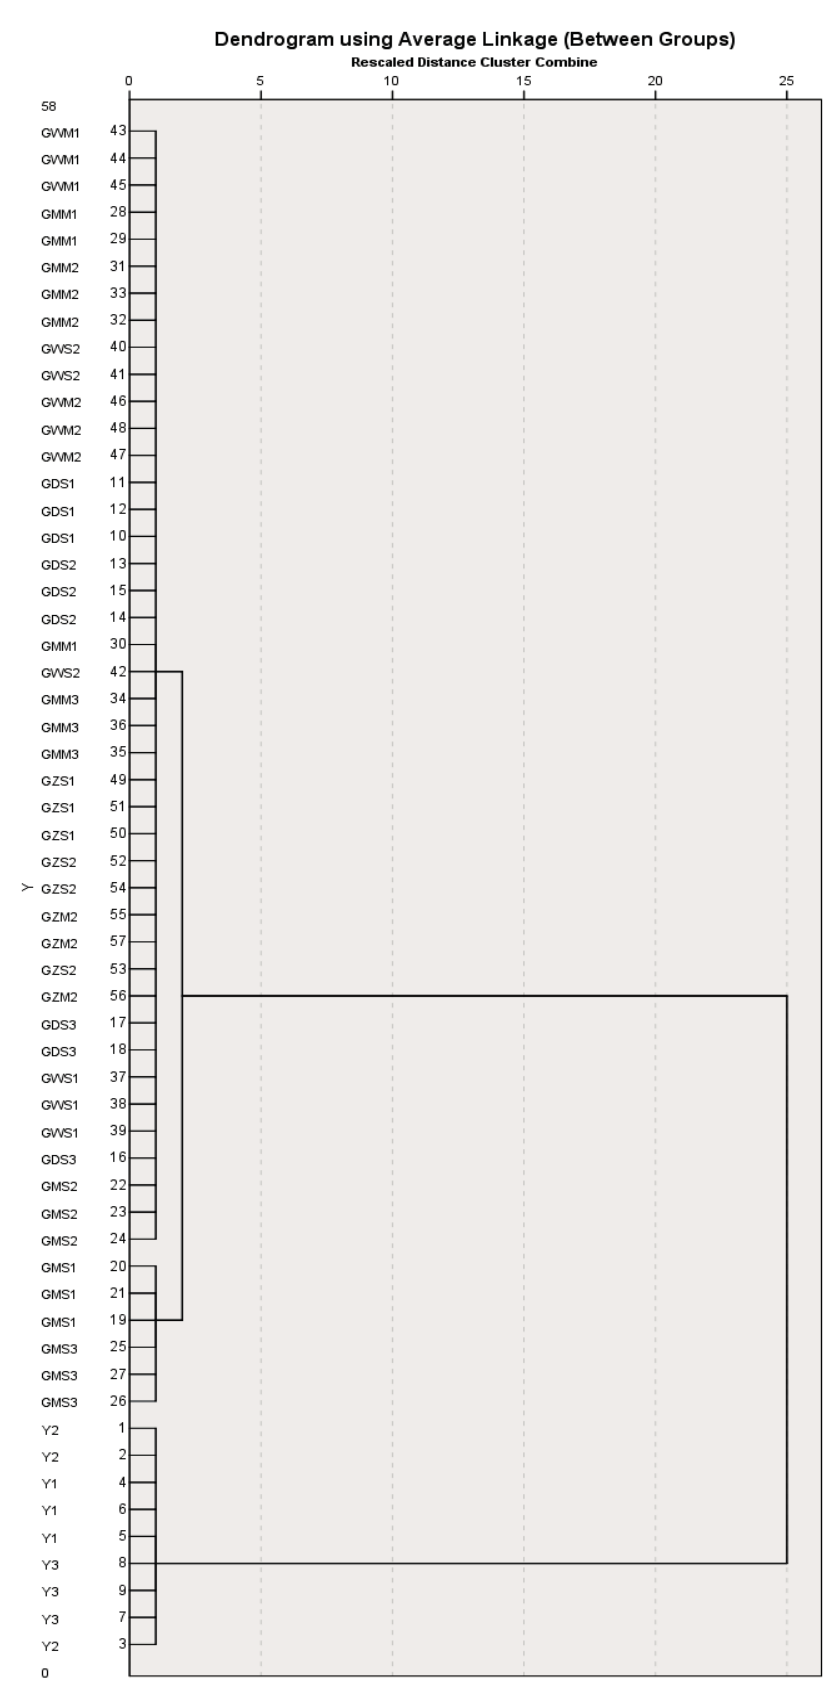
Figure 8. Hierarchical clustering analysis (HCA) dendrogram for samples